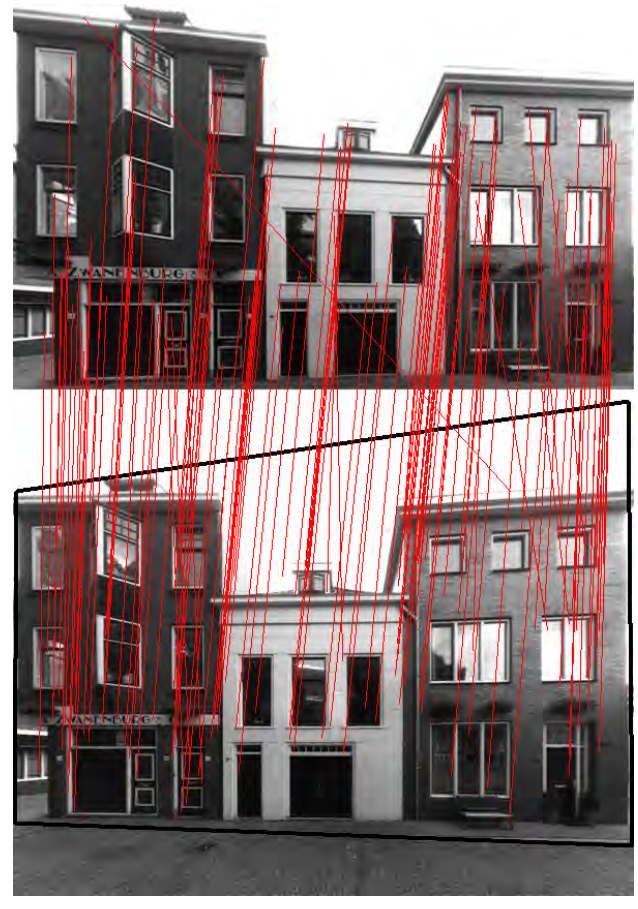
Figure 5. Homography estimation using extracted SURF in two images (red lines: linked SURF pairs; black quadrangle: homographic transformed viewing plane of the upper